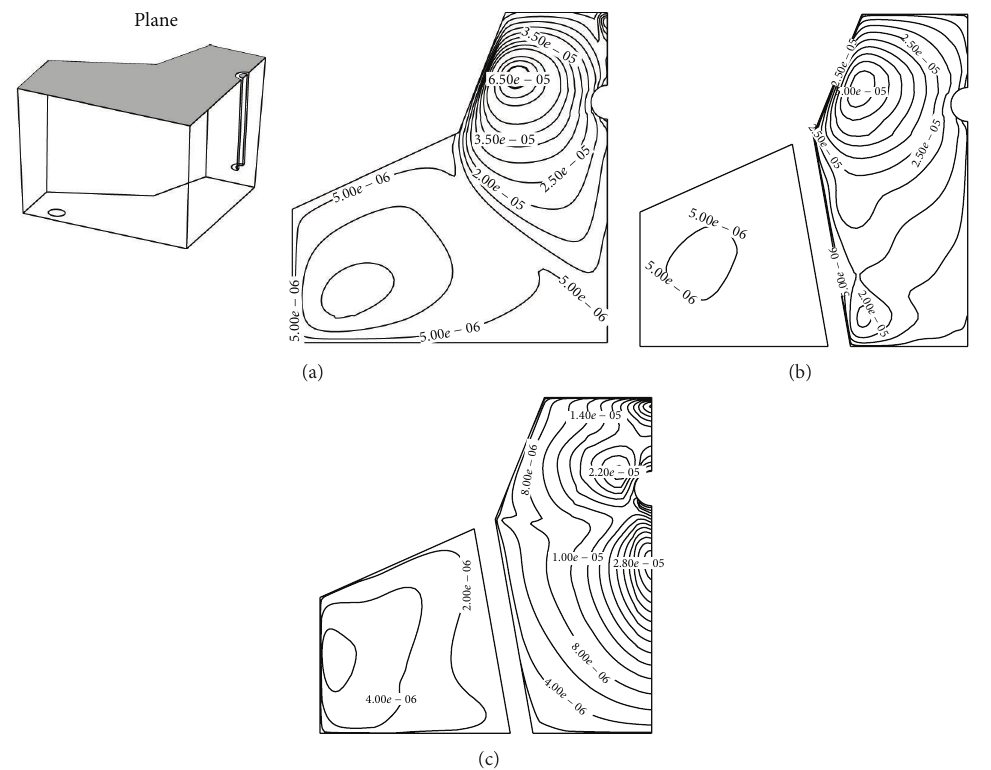
Figure 9: Predicted turbulent kinetic energy field in tundish for all cases: (a) Case I, (b) Case II, and (c) Case III.